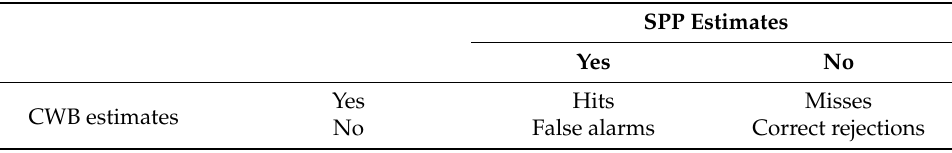
Table 1. Contingency table for calculated skill scores of threat score (TS), probability of detection (POD), and false alarm rate (FAR) between CWB and two SPPs.